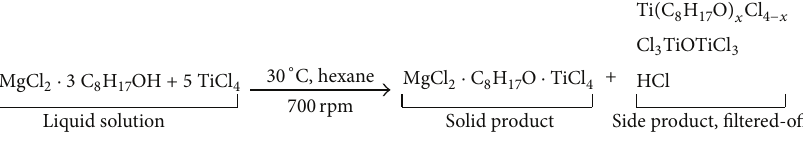
Scheme 1: Synthesis of the magnesium-supported Ziegler-Natta